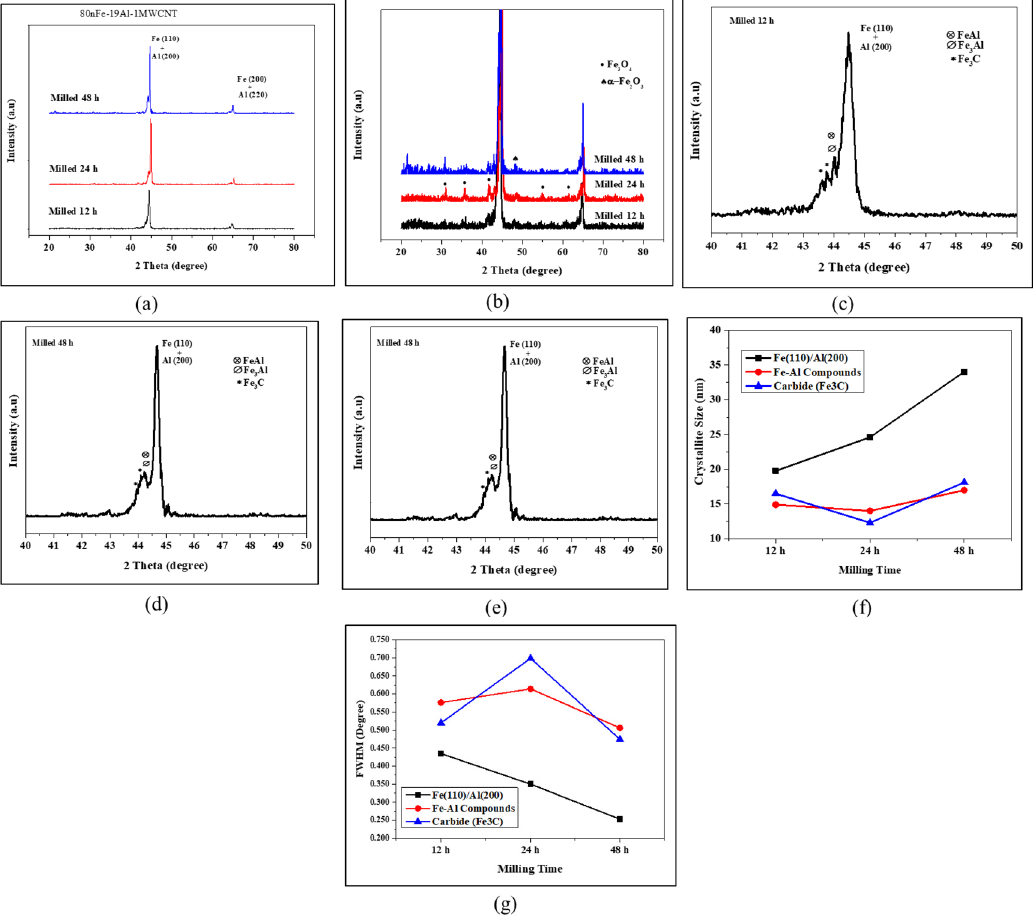
Figure 9. ( a ) Full scan of the XRD pattern of 80nFe-19Al-1MWCNT at different ball milling time; ( b ) detailed view of XRD patterns for small peaks observation; ( c – e ) zoom-in of the peaks in the angular range of 40–50° in case of powder milled for 12 h, 24 h and 48 h respectively; ( f ) crystallite size at a different milling time and ( g ) FWHM corresponding to the crystallite size in ( f ).